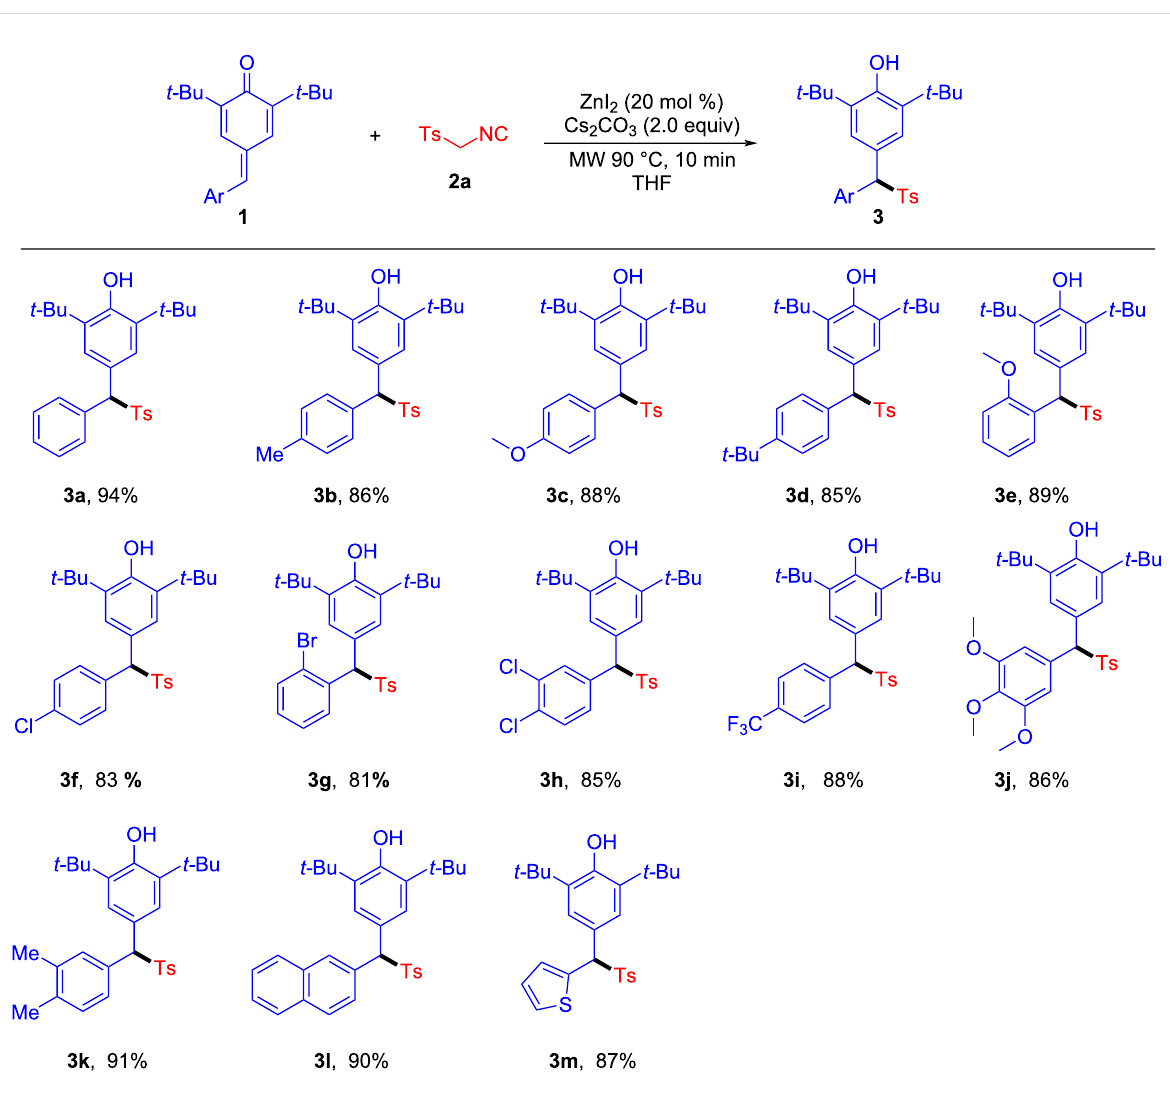
Scheme 2: ZnI 2 -catalyzed C–S-bond cleavage of TosMIC for the synthesis of diarylmethyl sulfones 3a–m . Reaction conditions unless otherwise specified: 1 (0.2 mmol), 2a (0.4 mmol), ZnI 2 (0.04 mmol), Cs 2 CO 3 (0.4 mmol), THF (1.0 mL), MW 90 °C, under air atmosphere for 10 min; yields are reported for the isolated